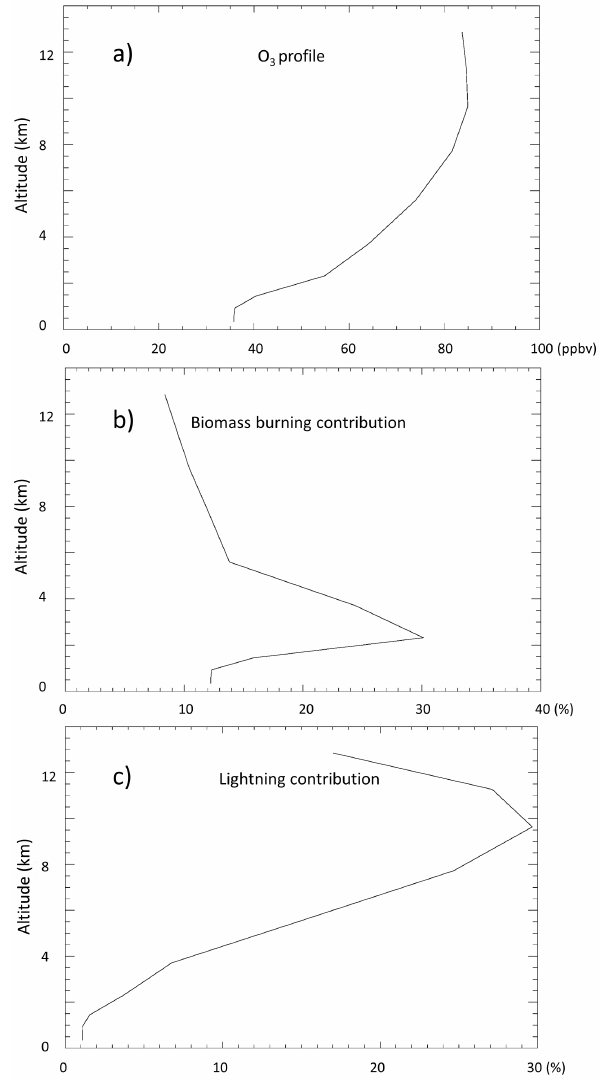
Figure 10. Vertical profiles of total O 3 concentrations (ppb) (a) with biomass burning (b) and lightning (c) contribution in percentage over the SAO (defined as an area within 25 ◦ S, 25 ◦ W and 5 ◦ S, 5 ◦ E) in future